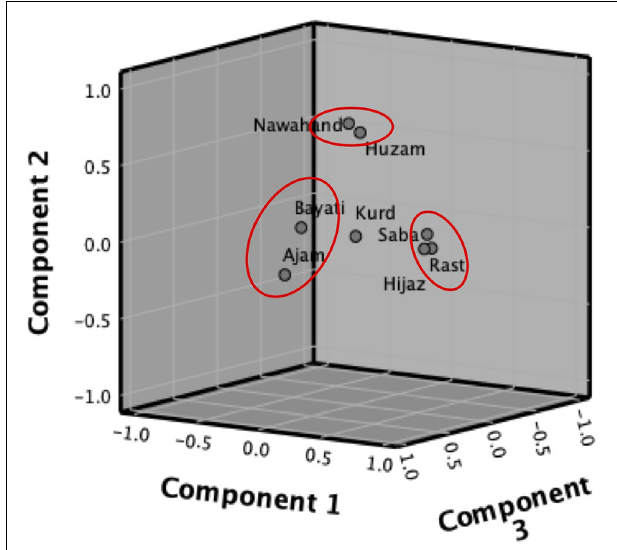
FIGURE 4 | Principal component analysis plot of the eight maqam commonly used in Middle Eastern Music. Detailed output available in Supplementary File 5